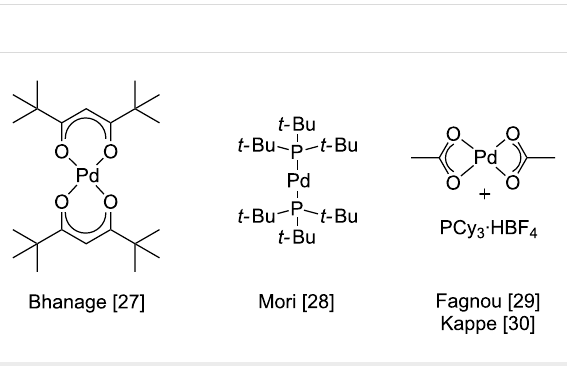
Figure 3: Previously reported catalytic systems in the direct arylation of benzothiophene ( 6